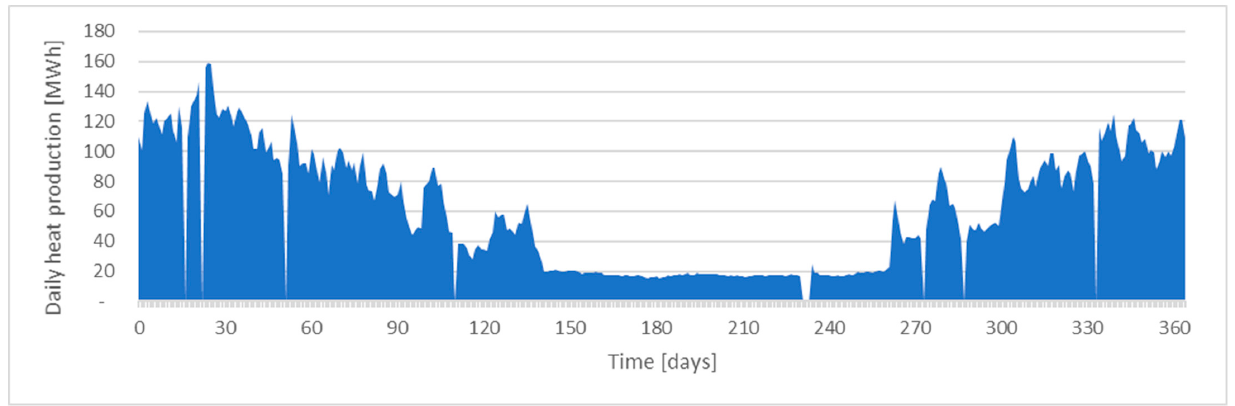
Figure 2. Accumulated daily heat production in 2019 in the heating plant.